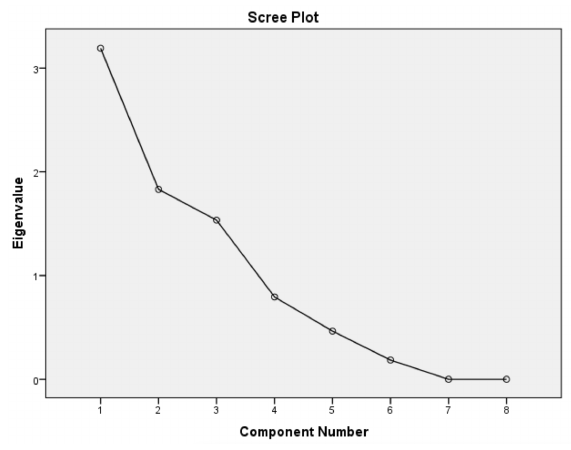
Figure 2. Scree plot for component’s eigenvalue based on PCA